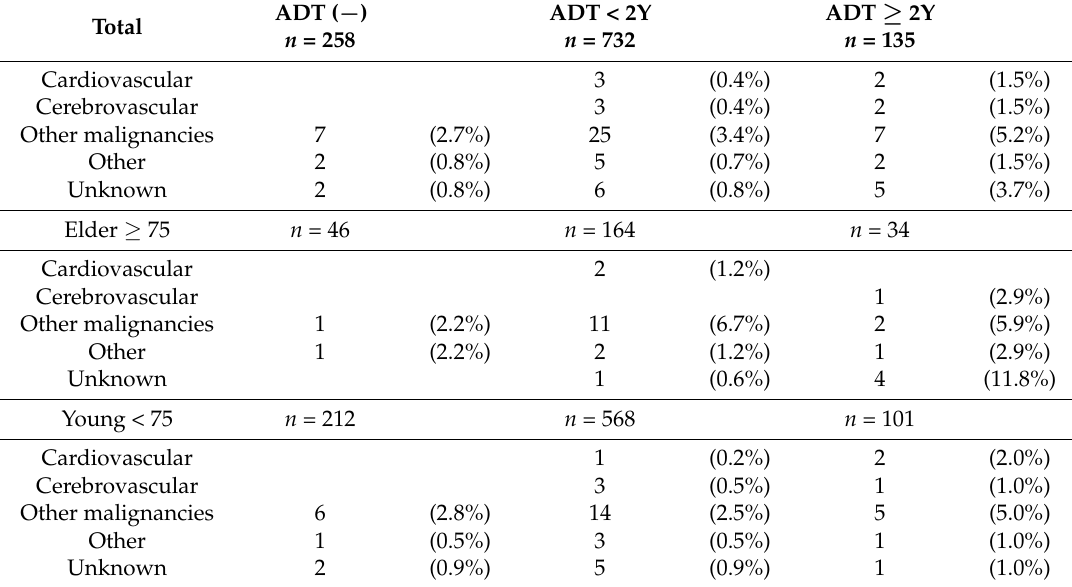
Table 6. Cause of other cause of mortality